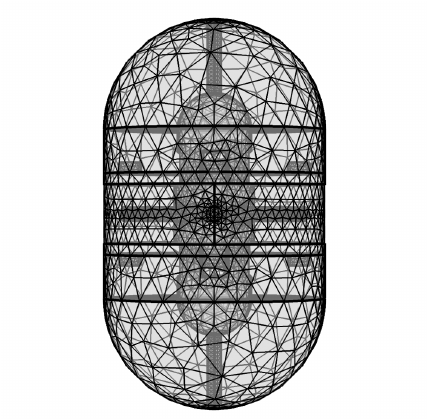
Figure 2. Bioreactor geometry volume mesh created using COMSOL Multiphysics, with 1.9 × 10 6 elements, and an average element quality of